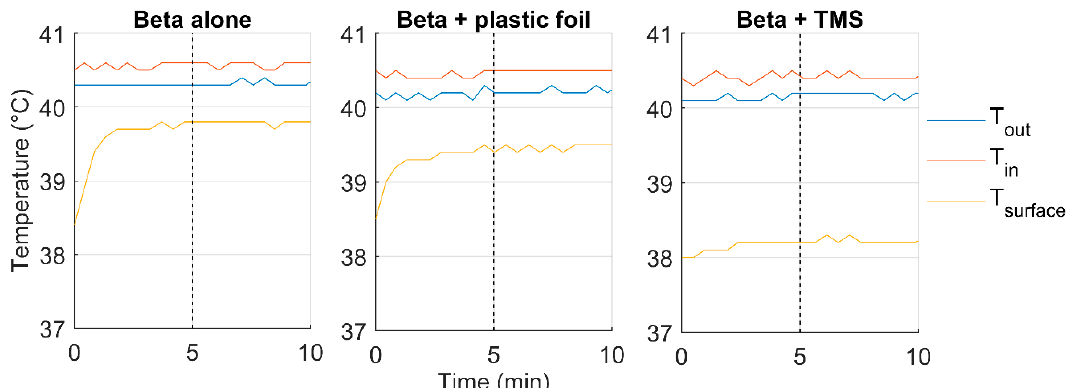
Figure 9. The effect of the 10 µm high density polyethylene plastic foil and thermal monitoring sheet (TMS) on the heat transfer of the water bolus of the Beta applicator. The 5 min steady state interval starts after the dotted vertical line. The median temperature of the inflow ( T in ), outflow ( T out ), and the median surface temperature ( T surface ) are presented during a 10 min interval.